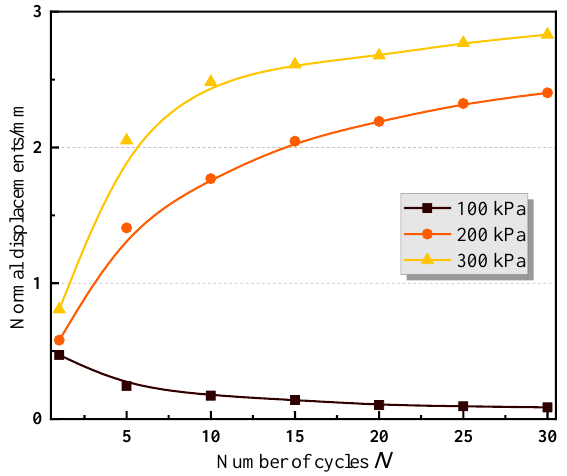
Figure 11. Curve for normal displacement – number of cycles under different constant normal stress.